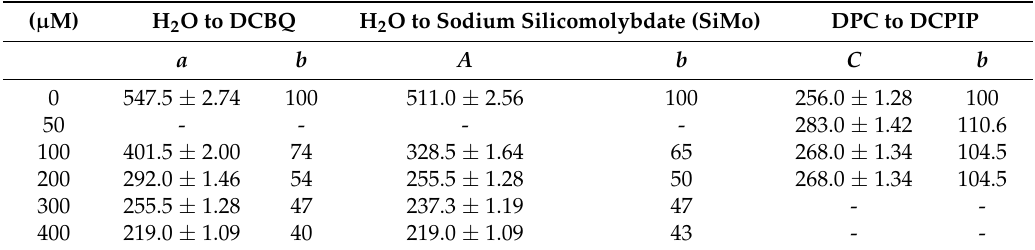
Table 2. Effects of arborinine ( 1 ) on photosynthetic electron transport on photosystem II (PSII). Note: DCPIP,